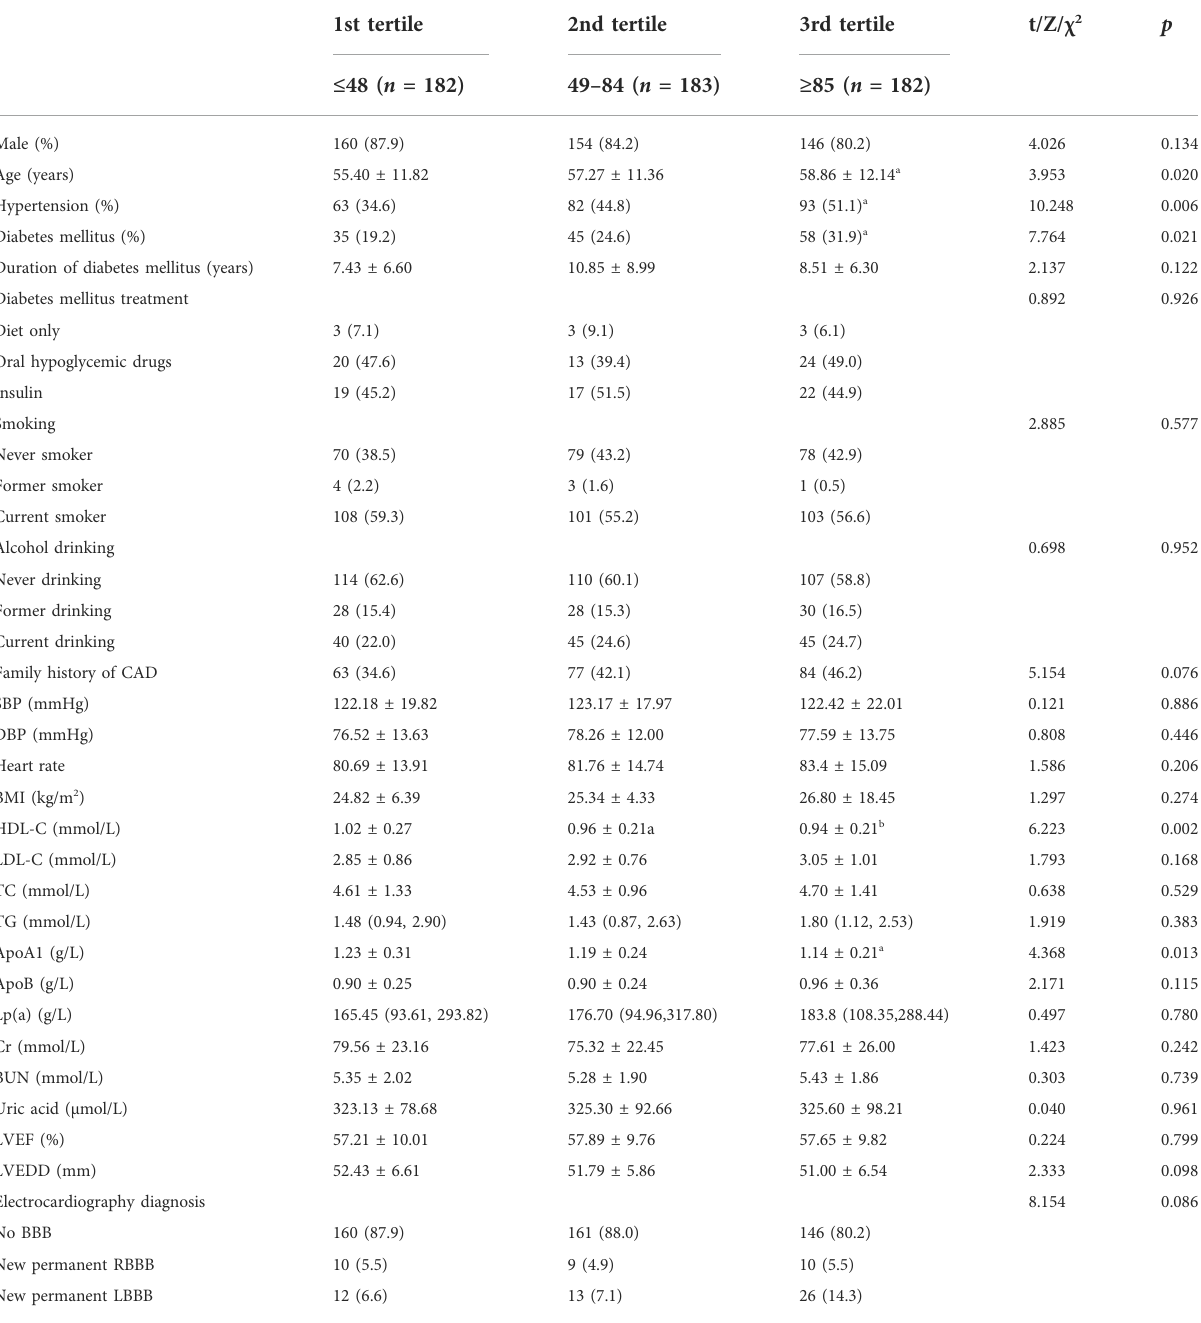
TABLE 3 Baseline characteristics of participants according to the Gensini score